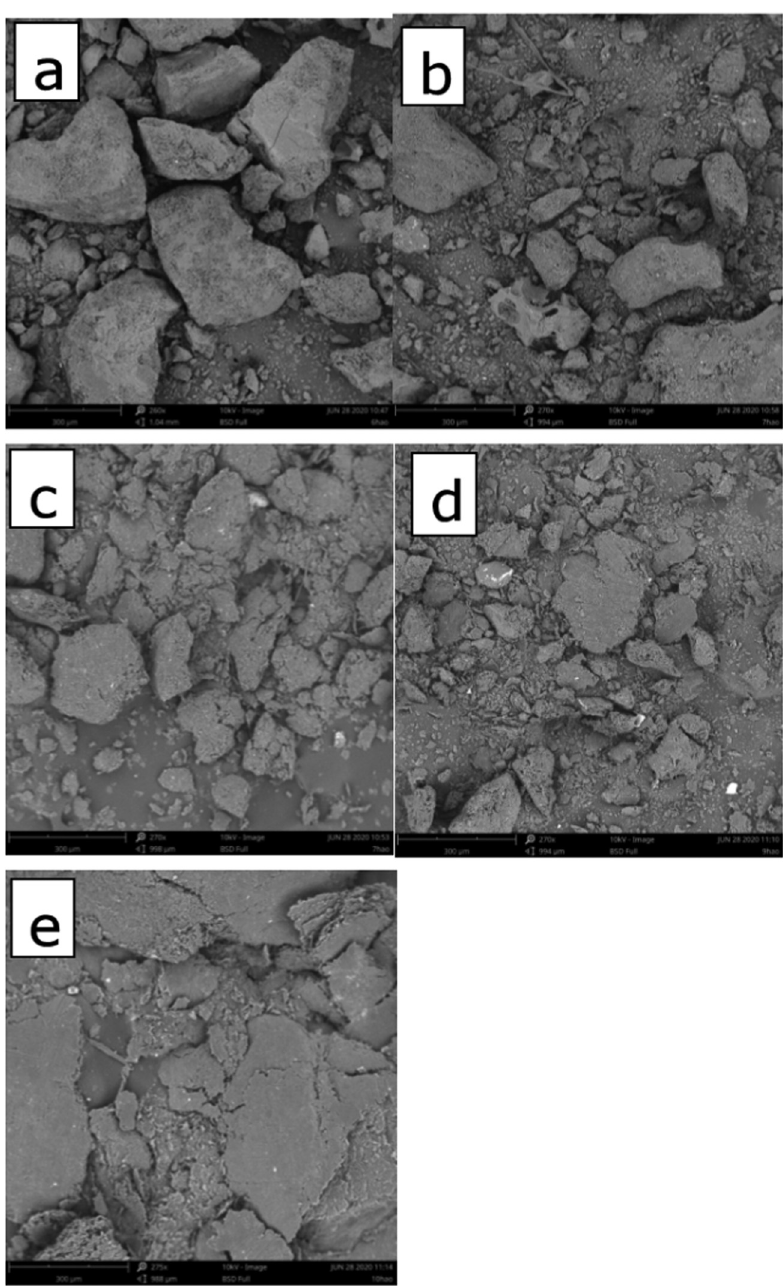
Figure 1: SEM images of the carbon solid acid catalysts prepared with di ff erent mass ratios of raw materials: ( a ) G/F - 1/4, ( b ) G/F - 1/3, ( c ) G/F - 1/2, ( d ) G/F - 1/1, and ( e ) G/F -